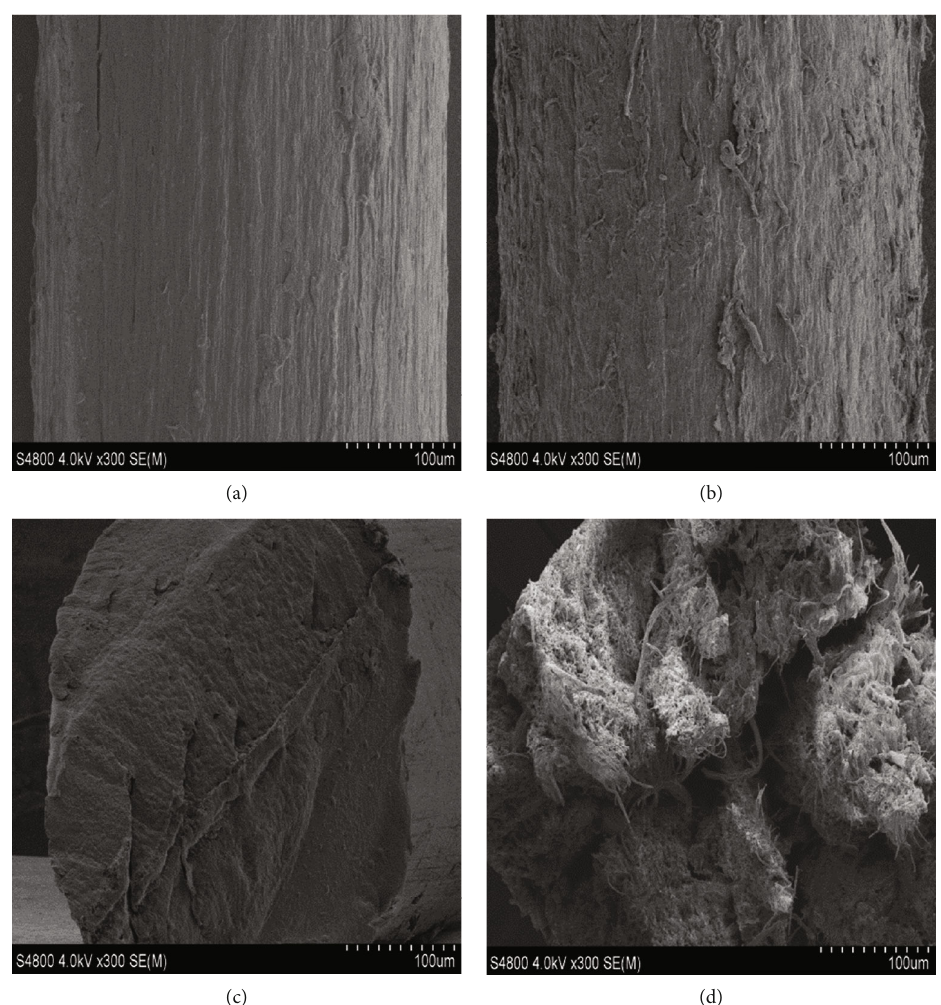
Figure 7: SEM images of starch-based composite fi bers before and after biodegradation in soil. (a) Surface of STR-80 before soil degradation. (b) Surface of STR-80 after soil degradation. (c) Fractural structure of STR-80 before soil degradation. (d) Fractural structure of STR-80 after soil